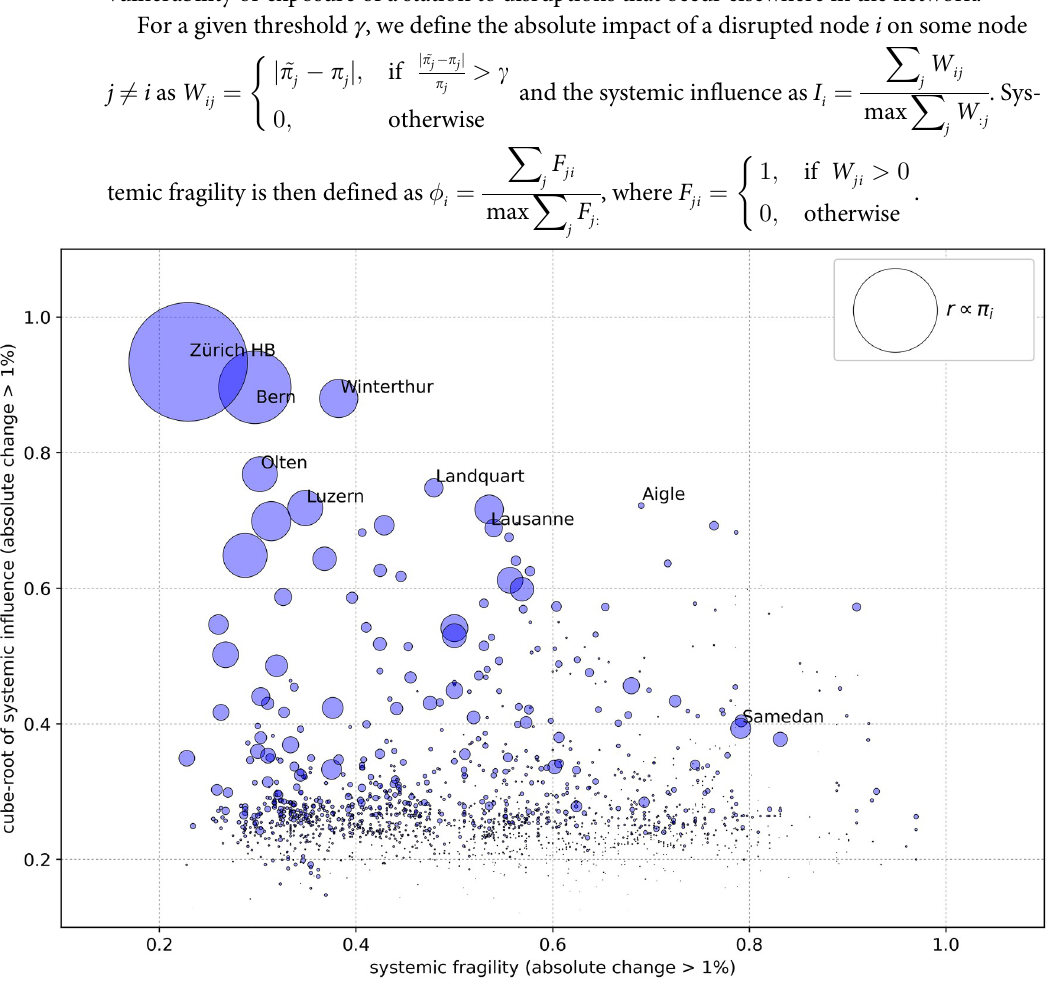
Fig 6. Systemic influence and systemic fragility of all Swiss train stations. Median values over a period of one month. Big and influential stations tend to be also less fragile, but this is not a universal trend.